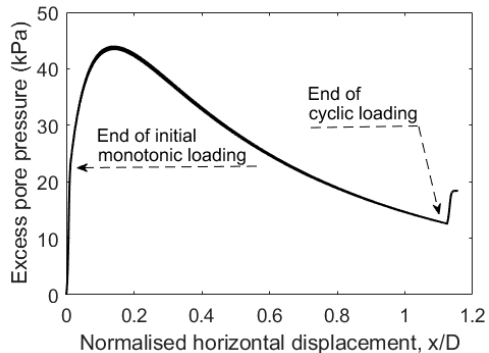
Figure 11. Evolution of soil strength: ( a ) υ – σ v ’ plane; ( b ) τ – σ v ’ plane. Figure 10. Excess pore water pressure generation during cyclic loading of the circular plate anchor.